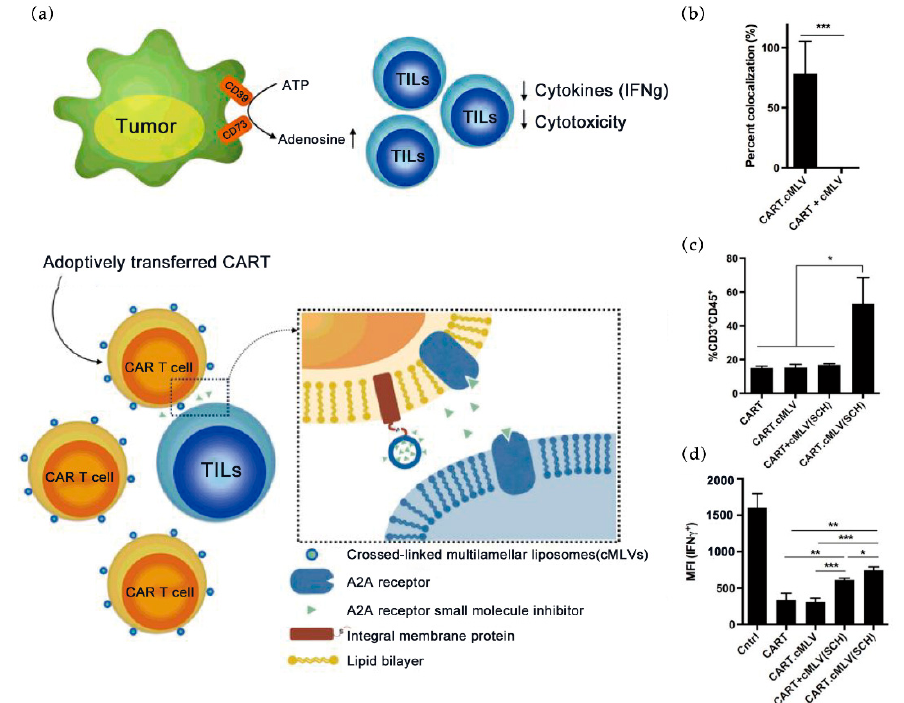
Figure 3. ( a ) Schematic diagram of cMLV-conjugated CAR-T cells in the presence of recipient cells in vivo; ( b ) percentage of tumor-infiltrating CAR-T cells that were colocalized with cMLVs inside the tumor tissues; ( c ) percentage of CD3 + CD45 + T cells in the tumor at day 2 after treatment; ( d ) intracellular IFN- γ secretion of tumor-infiltrating T cells upon ex vivo stimulation with anti-hCD3 and anti-hCD28 (2 μ g/mL of each) day 2 after treatments. ( ∗ p < 0.05, ∗∗ p < 0.01, ∗∗∗ p < 0.001) Repro- duced with permission from [30], © American Association for Cancer Research, 2018.